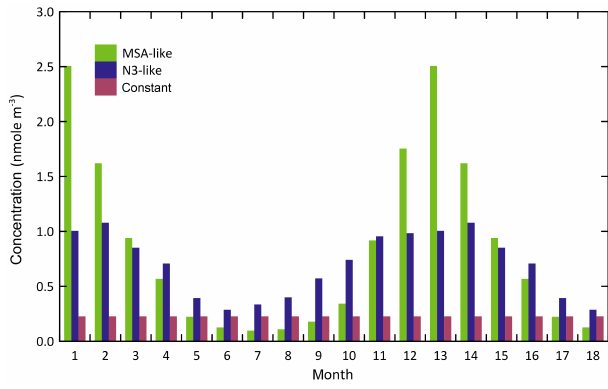
Figure 13. Multiple linear regression for non-sea-salt sulfate as a function of three parameters (MSA, N3,